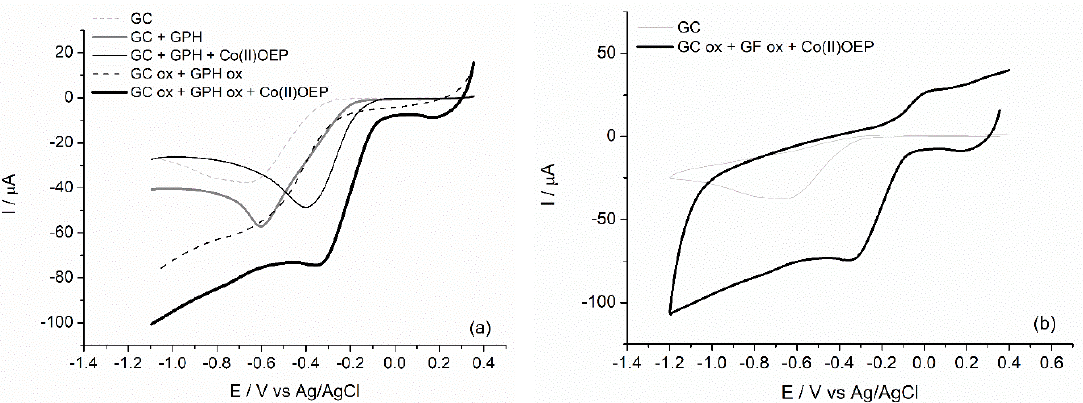
Figure 3. ( a ) Voltammetric profiles of all studied systems, ( b ) cyclic voltammetry profiles for GC and GC ox + GPH ox + Co(II)OEP systems, in 0.1 M NaOH saturated with O 2 . v = 0.1 Vs − 1 .